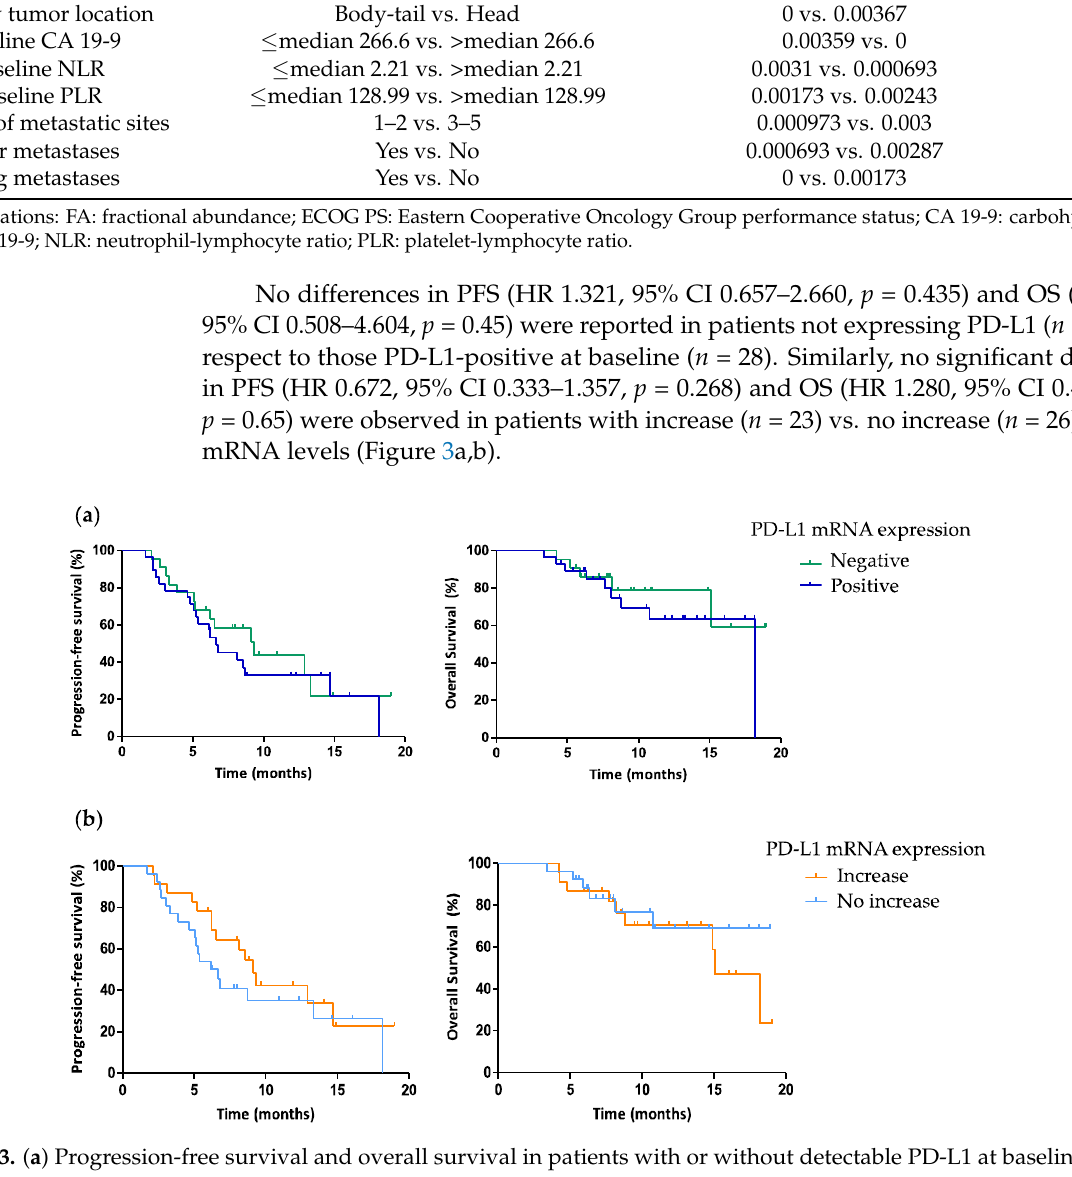
Figure 3. ( a ) Progression-free survival and overall survival in patients with or without detectable PD-L1 at baseline and ( b ) with increase vs. no increase in PD-L1 mRNA expression. Abbreviation: PD-L1, programmed death-ligand